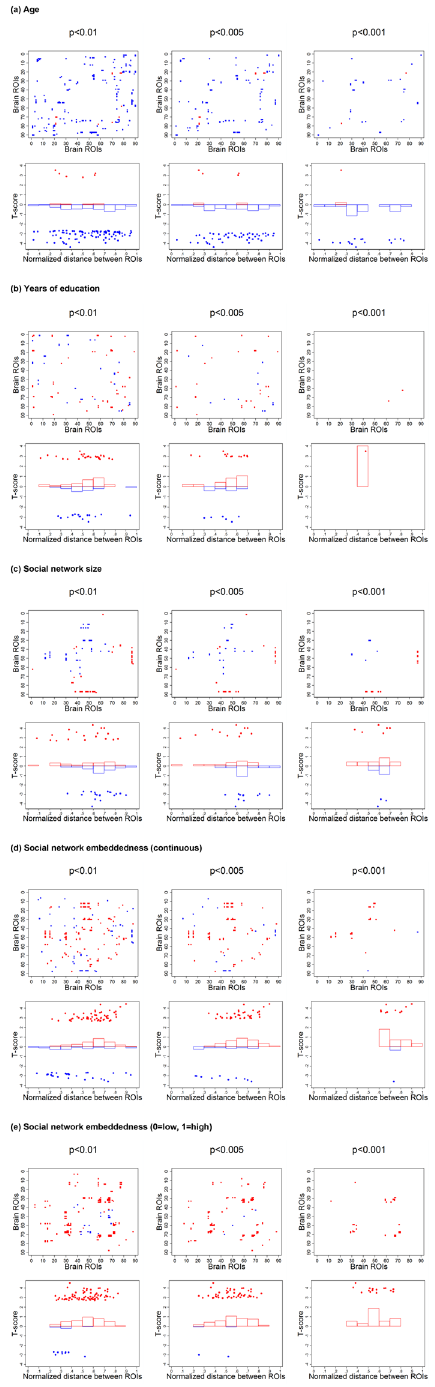
Figure 3. Pair-level associations between functional connectivity and individual characteristics. Blue/red dots represent negative/positive associations significant at the thresholds of p < 0.01, p < 0.005, or p < 0.001. Scatterplots in the first row are matrix representations of associations with functional connectivity among 90 by 90 brain ROIs. Scatterplots and histograms in the second row illustrate the associations by distance between brain ROIs. ( a ) Age was negatively associated with overall functional connectivity. ( b ) Years of education and ( c ) social network size showed associations with functional connectivity among only a few ROI-pairs at the level of p < 0.001, which did not show any trend in distance between ROIs. ( d ) Social network embeddedness (continuous) and ( e ) social network embeddedness (low = 0, high = 1) showed positive associations with functional connectivity, especially between long-distance ROIs in the